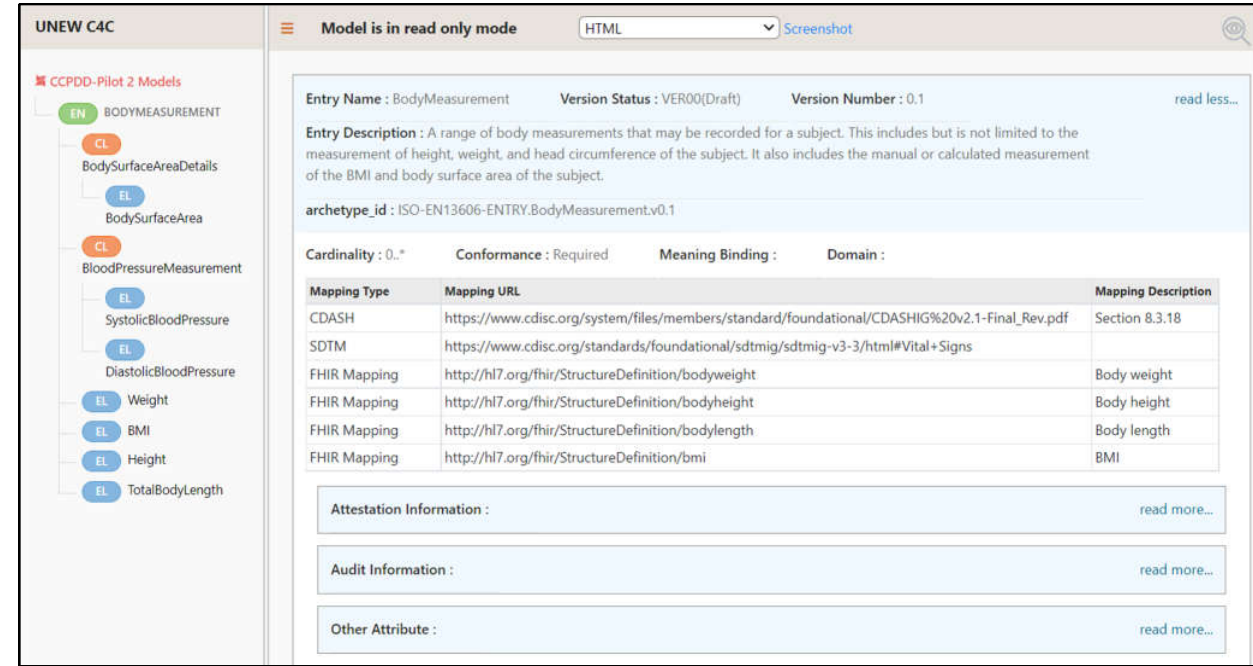
Figure 7. Image of the HTML version of the modelled data dictionary. SDTM—Study Data Tabula- tion Model; FHIR—Fast Healthcare Interoperability Resources; CDASH—Clinical Data Acquisition Standards Harmonisation; HTML—hypertext markup language.